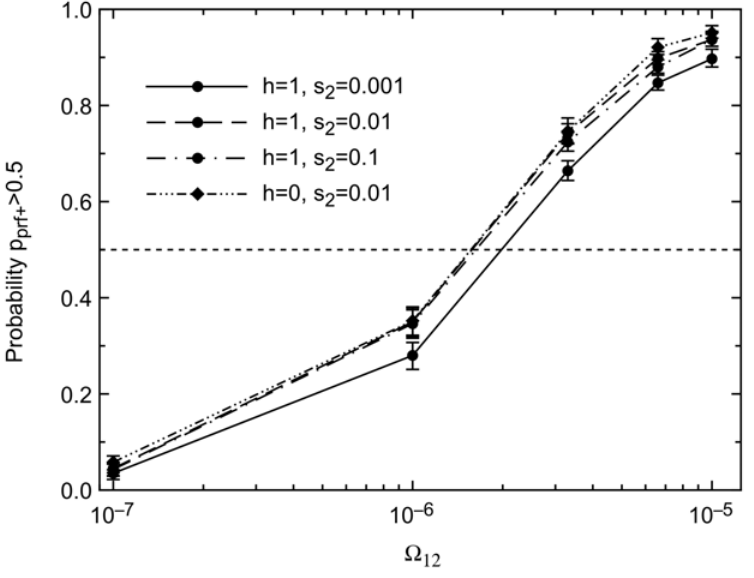
Figure 6. Very rare opportunities for adaptation (low V 12 ) cause prf + to be lost. e =0.01, V 21 =10 2 5 .